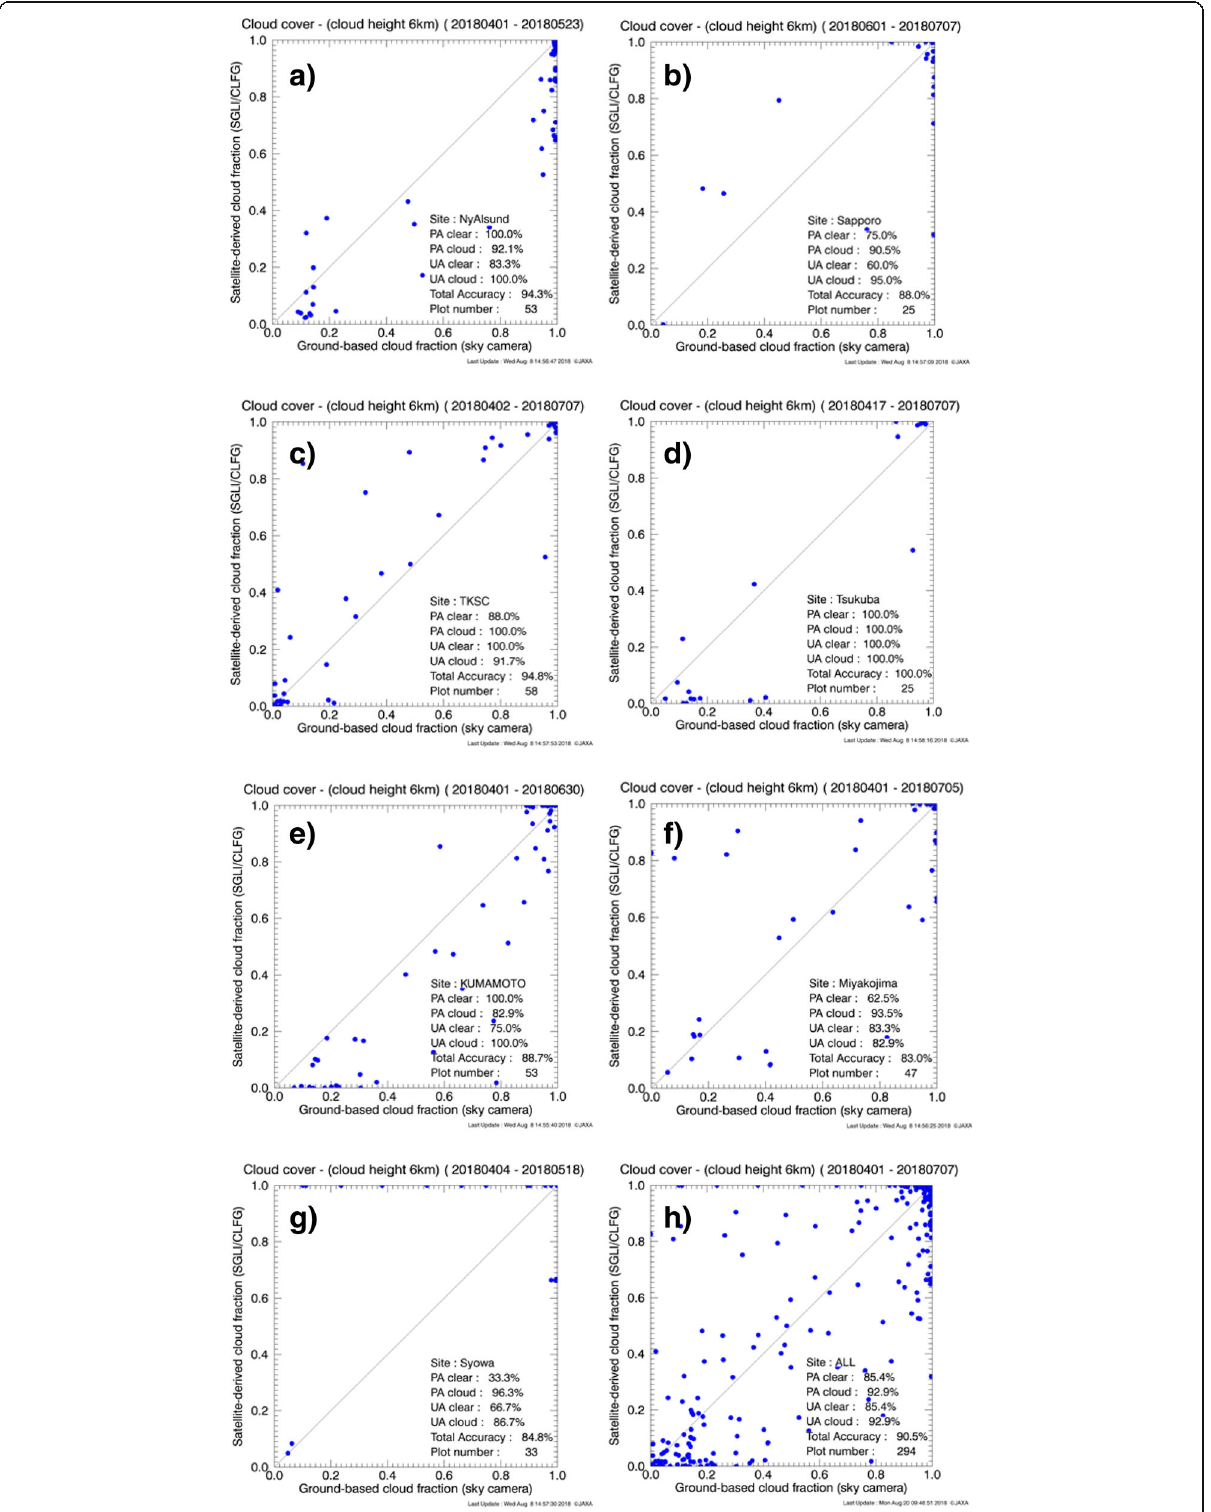
Fig. 11 Comparison of cloud fractions based on ground-based sky camera observations with those derived from SGLI data using the CLAUDIA algorithm. Observations taken from a ) Ny-Alesund, b ) Sapporo, c ) Tsukuba (TKSC), d) Tsukuba (MRI), e ) Kumamoto, f ) Miyakojima, g ) Syowa Station, and h ) all